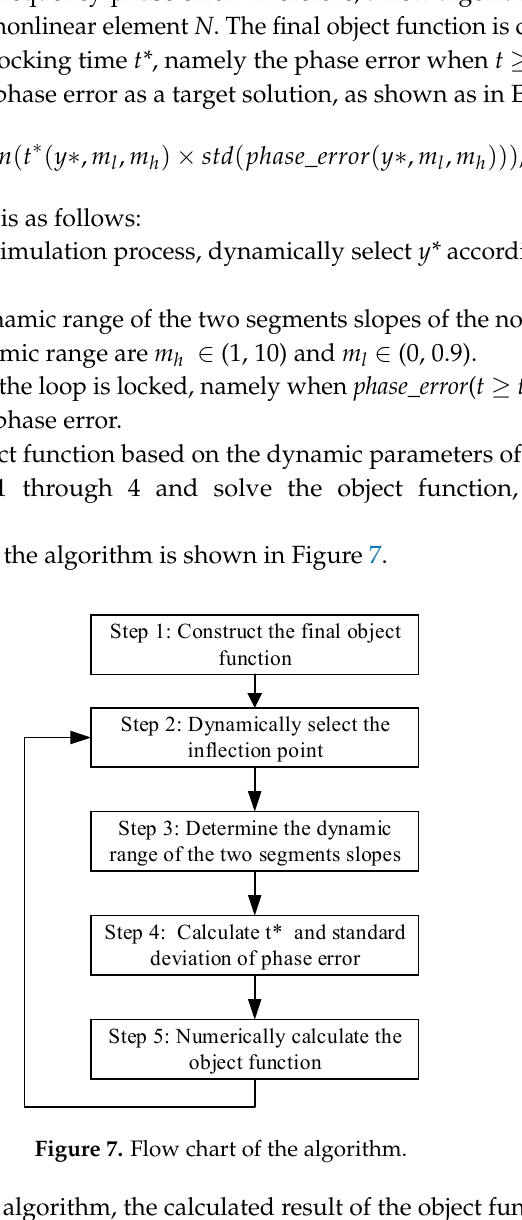
Figure 6. Phase error when y* changes.